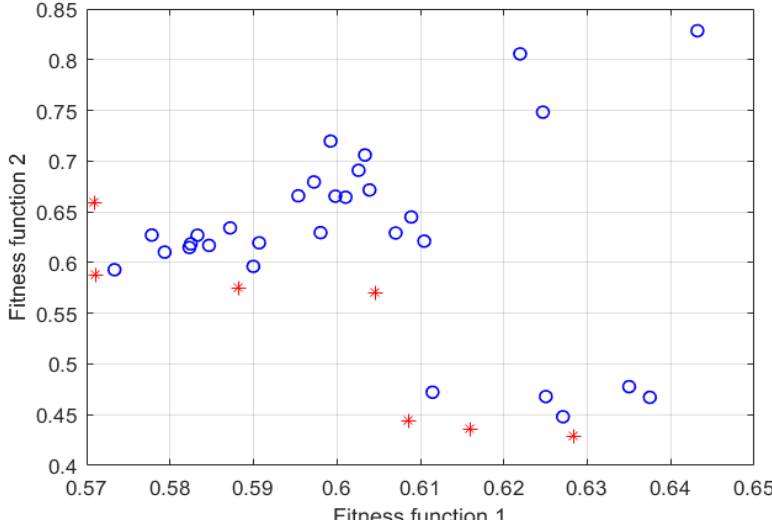
Figure 8. The solution set of VMD parameter optimization based on MOPSO. (where, o represents the non-dominant solution set, and * represents the Pareto optimal solution set).